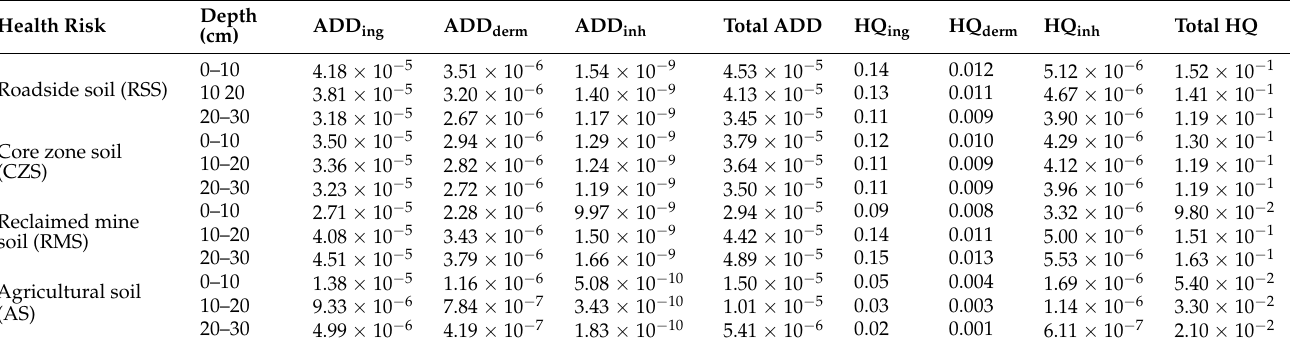
Table 2. Average daily dose (ADD) and hazard quotient (HQ) of As in three soil profiles (0–10, 10–20 and 20–30 cm) of different land-use areas of coal mine, Jharia coalfield.